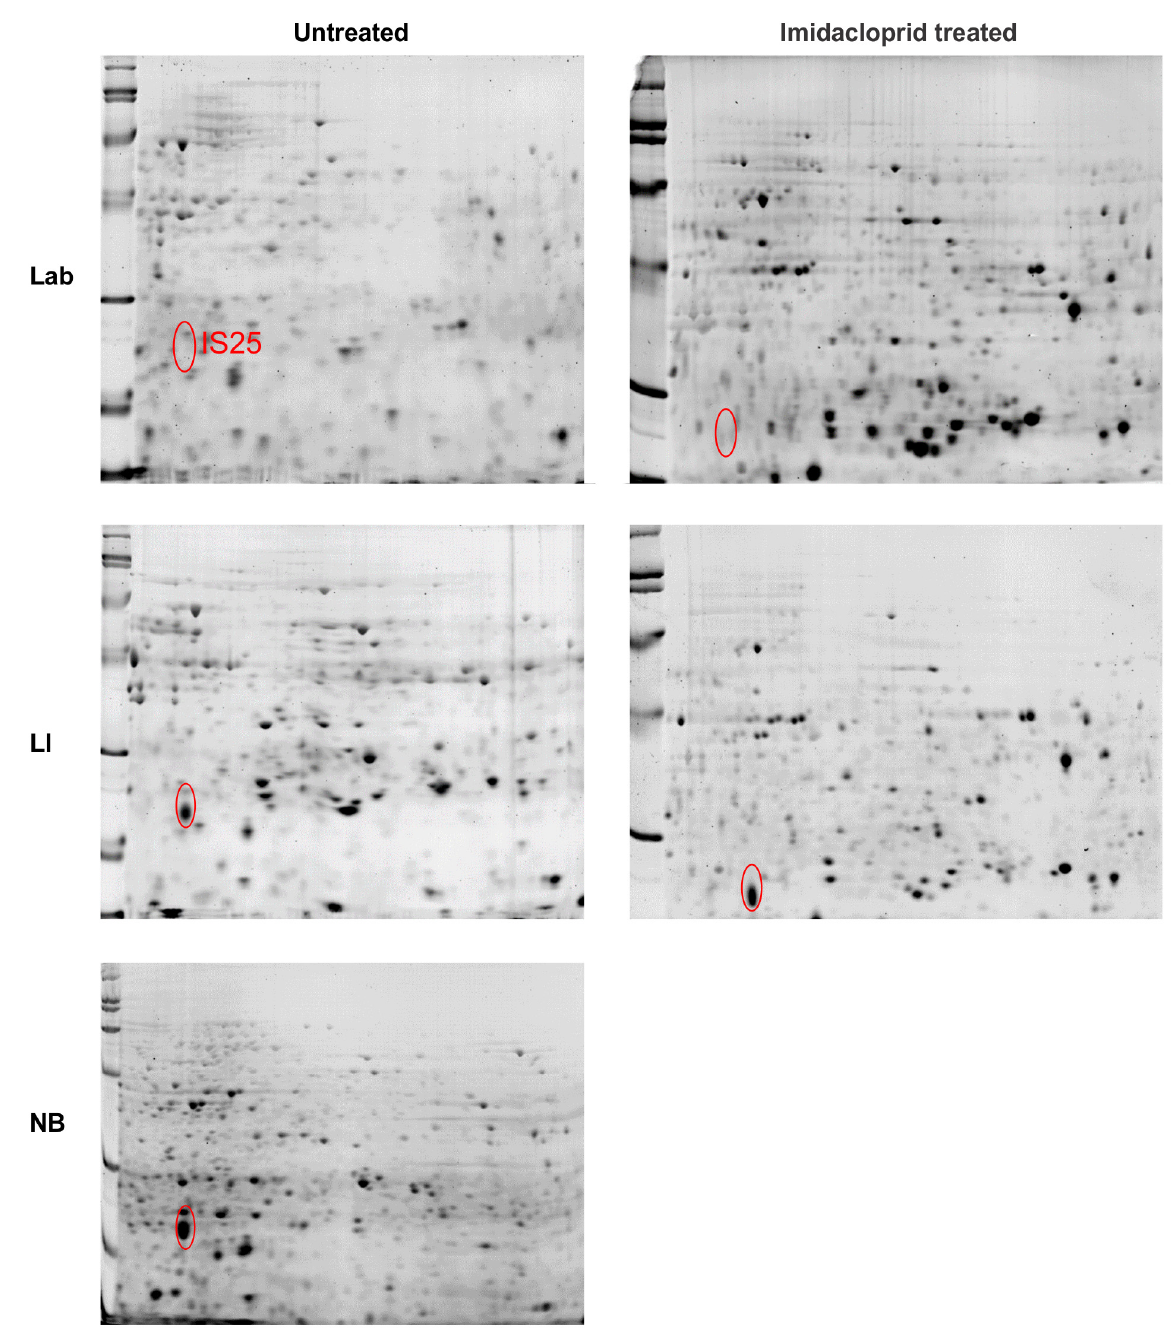
Figure 4. 2-dimensional polyacrylamide gel electrophoresis (2D PAGE) gel separations of adult Colorado potato beetle abdominal content (minus midgut) proteins from insecticide susceptible (Lab), resistant (LI) and tolerant (NB) strains. Strips 13 cm in length were run at pH 4–7 and cut to 7cm. The location of one high concentration protein spot (IS25) in the resistant and tolerant strains (LI and NB) was marked in the gels for each strain, either pre-treated with imidacloprid or untreated.